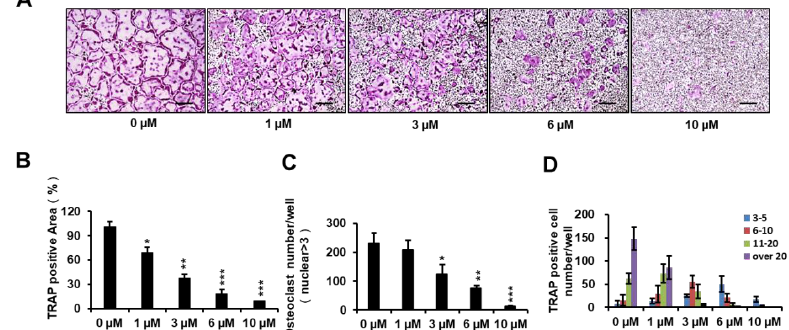
Figure 2. PPOA- N -Ac-2-Cl inhibits RANKL-induced osteoclastogenesis in a dose-dependent manner. ( A ) Inhibitory effect of PPOA- N -Ac-2-Cl on osteoclastogenesis, as observed by TRAP staining. BMMs were cultured with various concentrations of PPOA- N -Ac-2- Cl (0, 1, 3, 6, and 10 μM) for 4 days in the induction medium, containing M-CSF (30 ng/mL) and RANKL (50 ng/mL); subsequently, TRAP staining was performed to visualize osteoclast formation. Scale bar = 200 μ m. The area ( B ), number ( C ) of TRAP-positive multinuclear cells and the TRAP positive cell number based on the number of nuclei ( D ) were calculated. * p < 0.05, ** p < 0.01, and *** p < 0.001 versus vehicle-treated control (0 μM ).